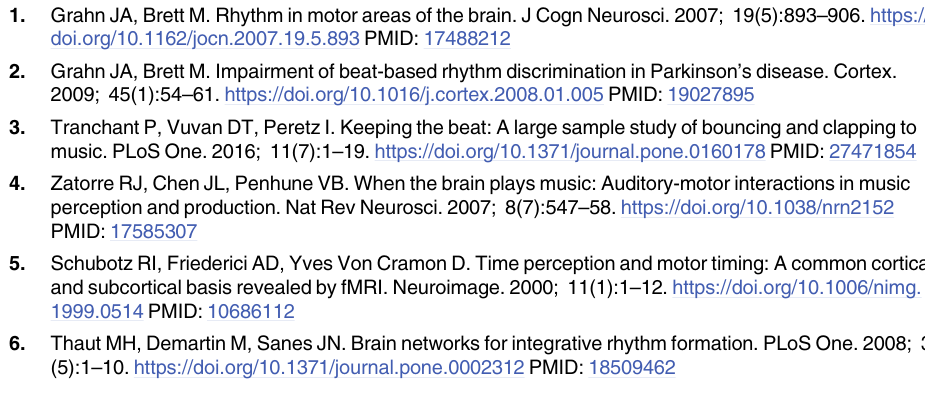
S1 Fig. Stimuli used in beat alignment perception test v1.0. Note: The order of the musical excerpts was